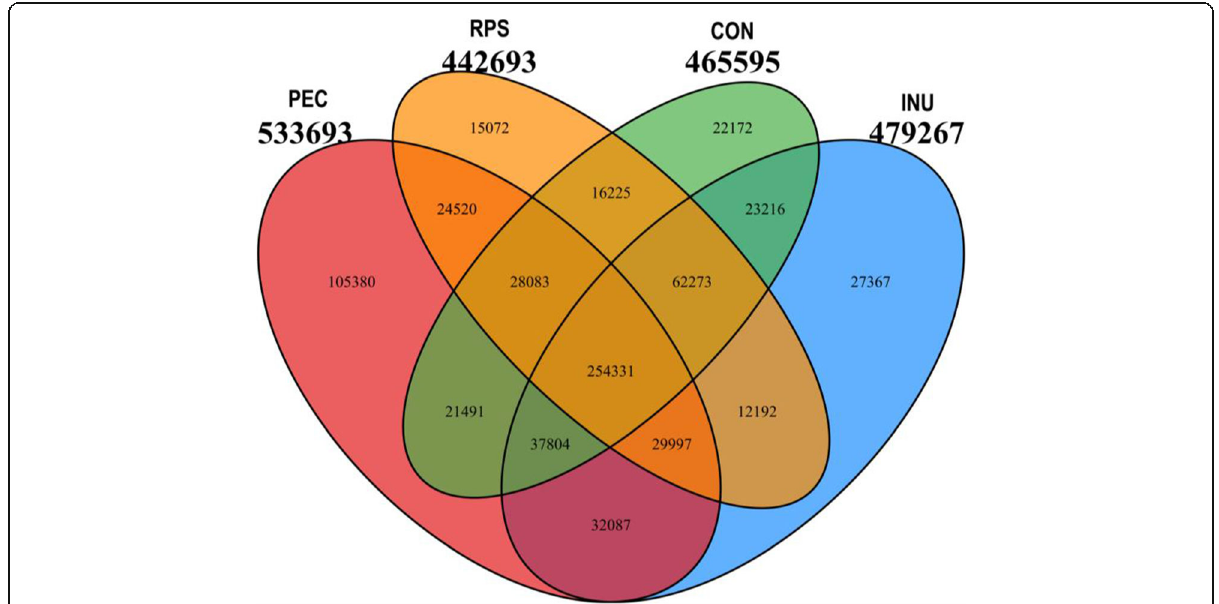
Fig. 1 Species Venn analysis. Venn diagram showing the common and unique species in the colons of the pigs fed with the control (CON), inulin